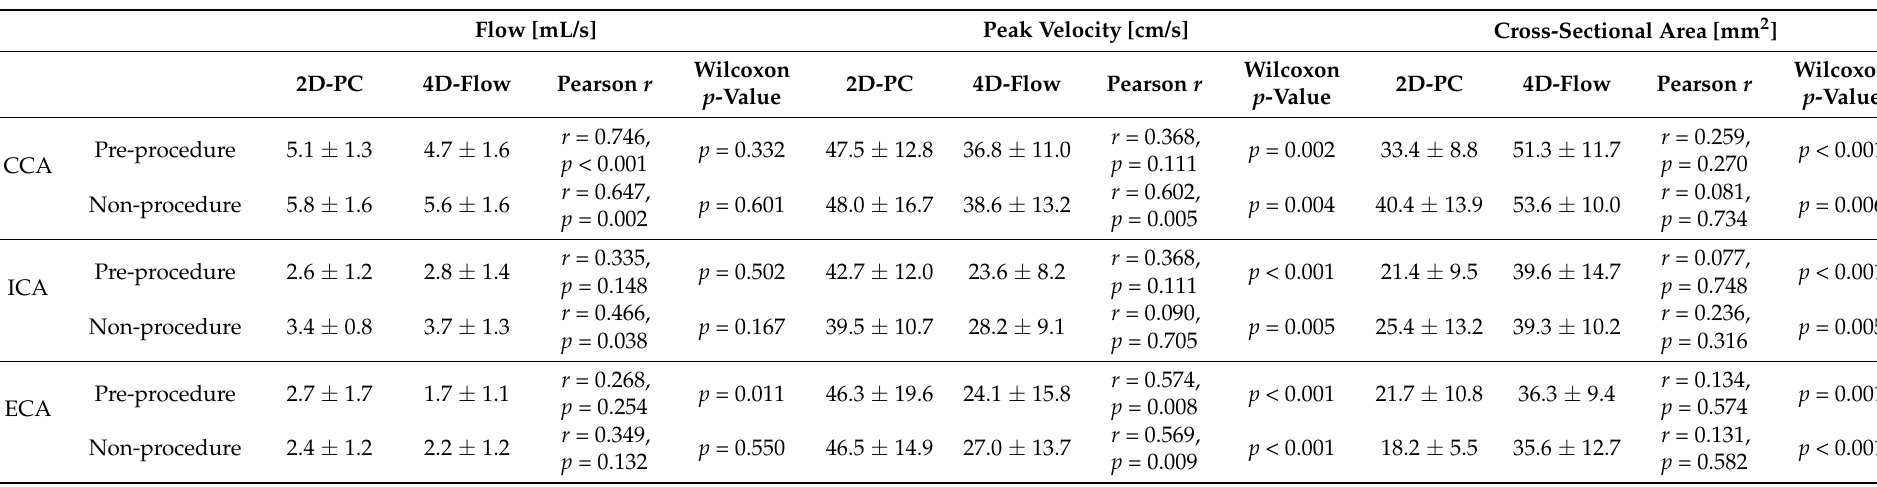
Table 2. Mean flow, peak velocity, and average cross-sectional area for the pre-procedure and non-procedure side in the study